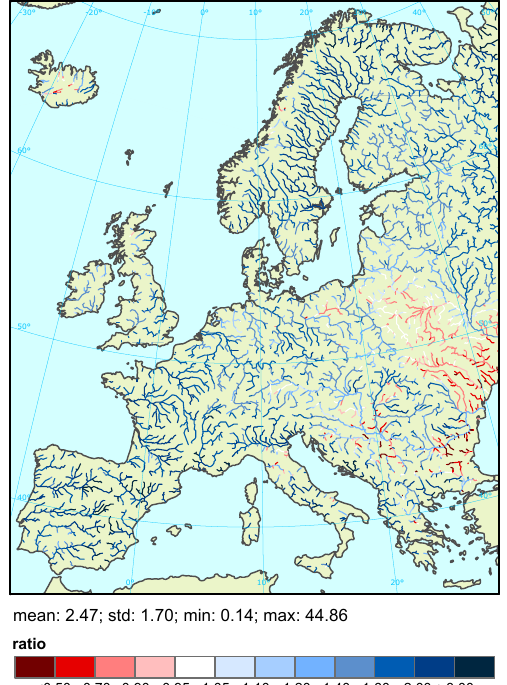
Fig. 12. Ratio of discharges for a return period of 100 yr between hydrologic simulations driven by uncorrected and bias corrected forcing data for the control period